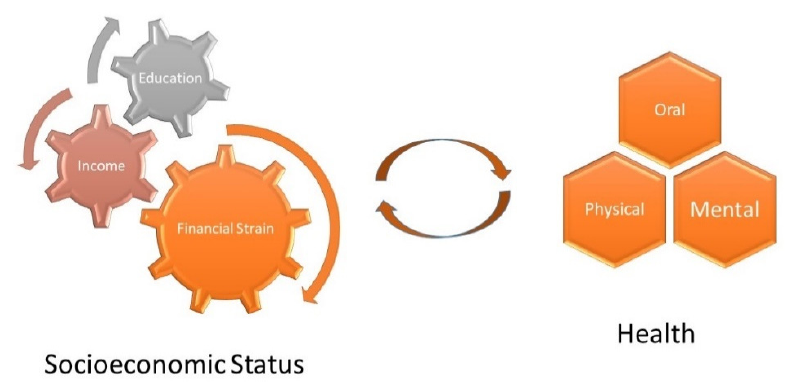
Figure 1. Study conceptual